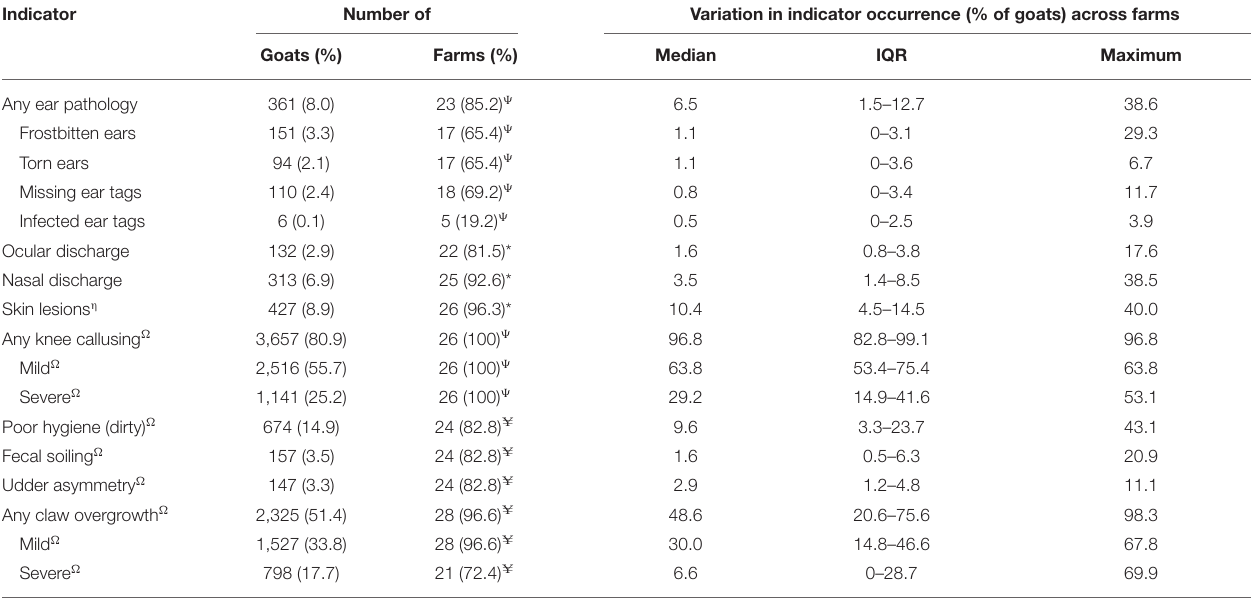
TABLE 5 | Individual-level welfare indicators observed for 4,524 goats on 30 farms across the Midwestern United States during on-farm welfare assessment at milking. Indicator Number of Variation in indicator occurrence (% of goats) across farms Goats (%) Farms (%) Median IQR Maximum Any ear pathology